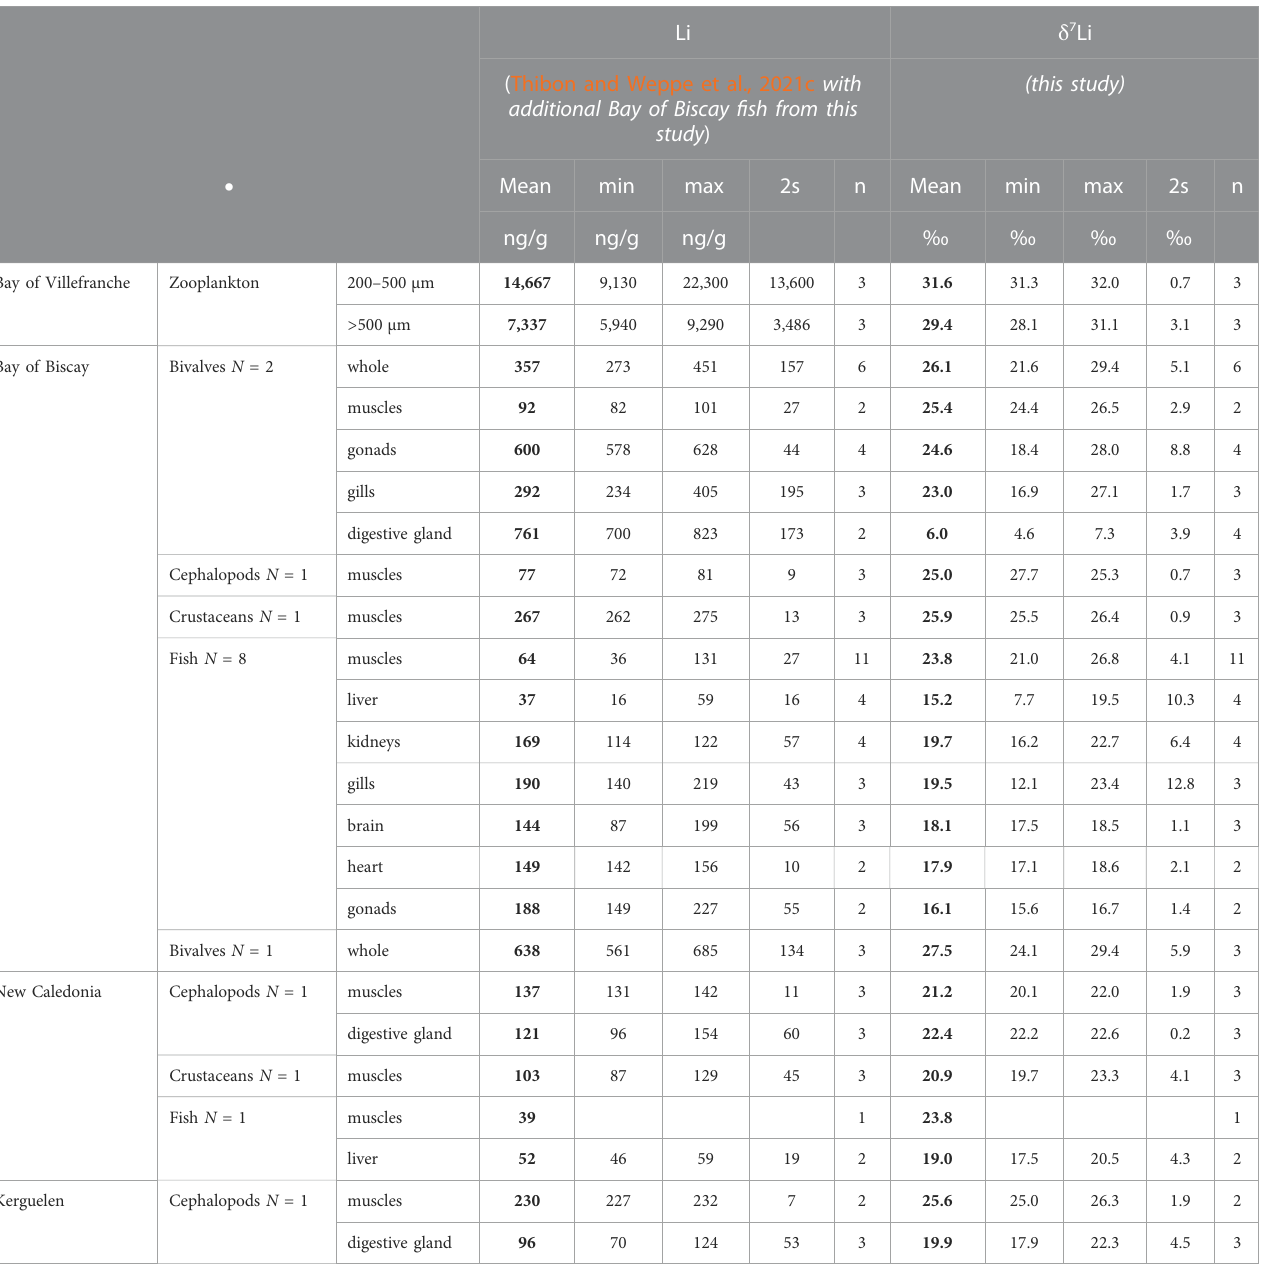
TABLE 1 Lithium mass fractions and its isotope compositions of the collected samples. The mean (in bold), minimum, maximum, and twice the standard deviation (2s) arereported. “ N ” indicates the number of species, “ n ” indicatesthe number ofindividuals forbivalves,cephalopods,crustaceans, and fi sh,andthe number of samples for plankton.